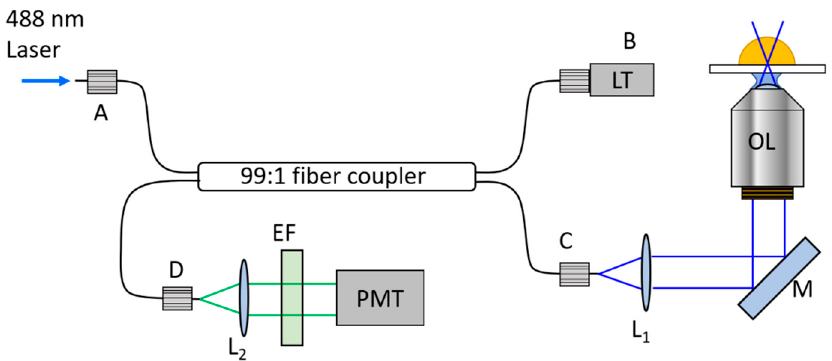
Figure 1. Experimental setup. LT, light trap. L, lens. M, mirror. OL, objective lens. EF, emission filter. PMT, photomultiplier tube.